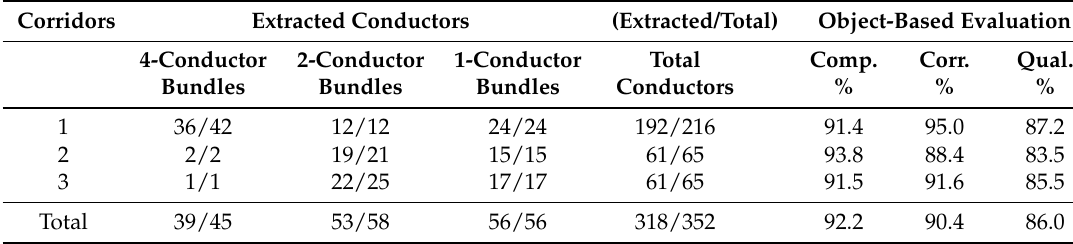
Table 7. Objected-based evaluation of conductor extraction at the Bindebango